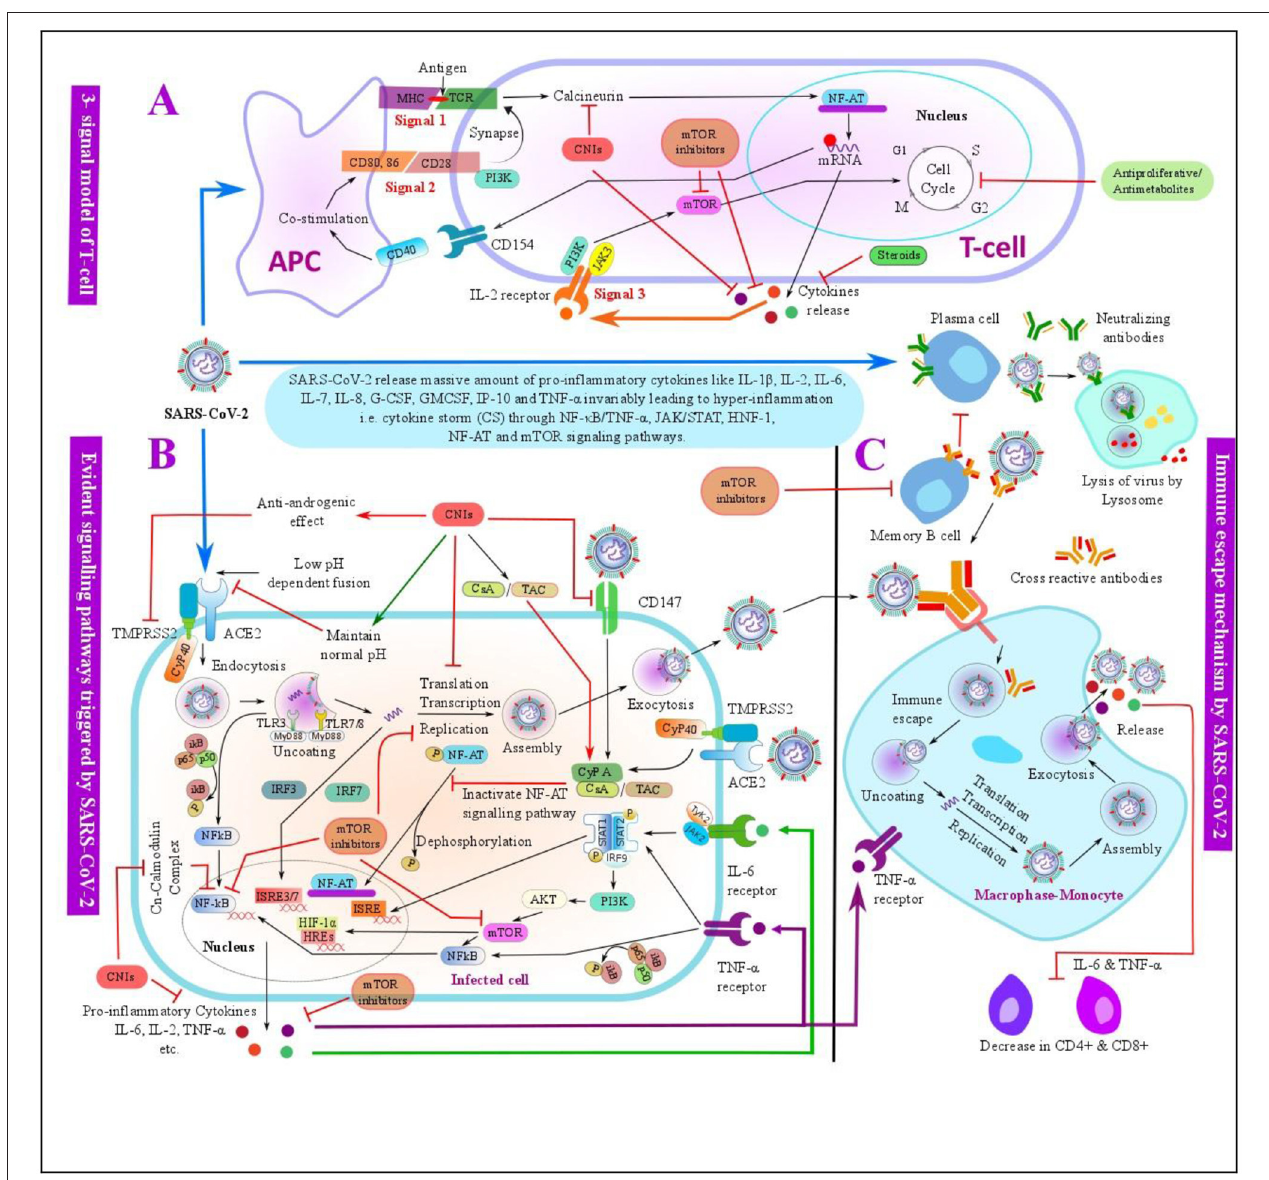
FIGURE 6 | Schematic overview of the evident pathways triggered by severe acute respiratory syndrome coronavirus 2 (SARS-CoV-2) infection and the possible mechanisms of immunosuppressants (ISs) used in the LT with its anti-SARS-CoV-2 effects. (A) Three-signal model of the T-cell: SARS-CoV-2 antigen is presented by an antigen-presenting cell (APC) to the T-cell by binding the major histocompatibility complex (MCH) to T-cell receptor (TCR), this further triggers the T-cell signal for an activation and proliferation of the T-cells. Costimulator molecules and its ligand bind at signal 2, which further synapse to TCR at the signal 1. The activation of signals 1 and 2 results in the release of interleukin-2 (IL-2) and other factors. The release of IL-2 further activates an IL-2 receptor on the T-cell surface, which triggers signal 3 for T-cell activation and proliferation. These signals can be inhibited by ISs such as CNIs, antiproliferative/antimetabolites, corticosteroids, and mTORis at various steps. (B) Evident pathways triggered by SARS-CoV-2 infection- SARS-CoV-2 may trigger intracellular pathways such as IFN regulatory factor-3 (IRF3), nuclear factor κ B/tumor necrosis factor- α (NF- κ B/TNF- α ), janus kinase/signal transducers and activators of transcription (JAK/STAT), nuclear factor of activated T-cells